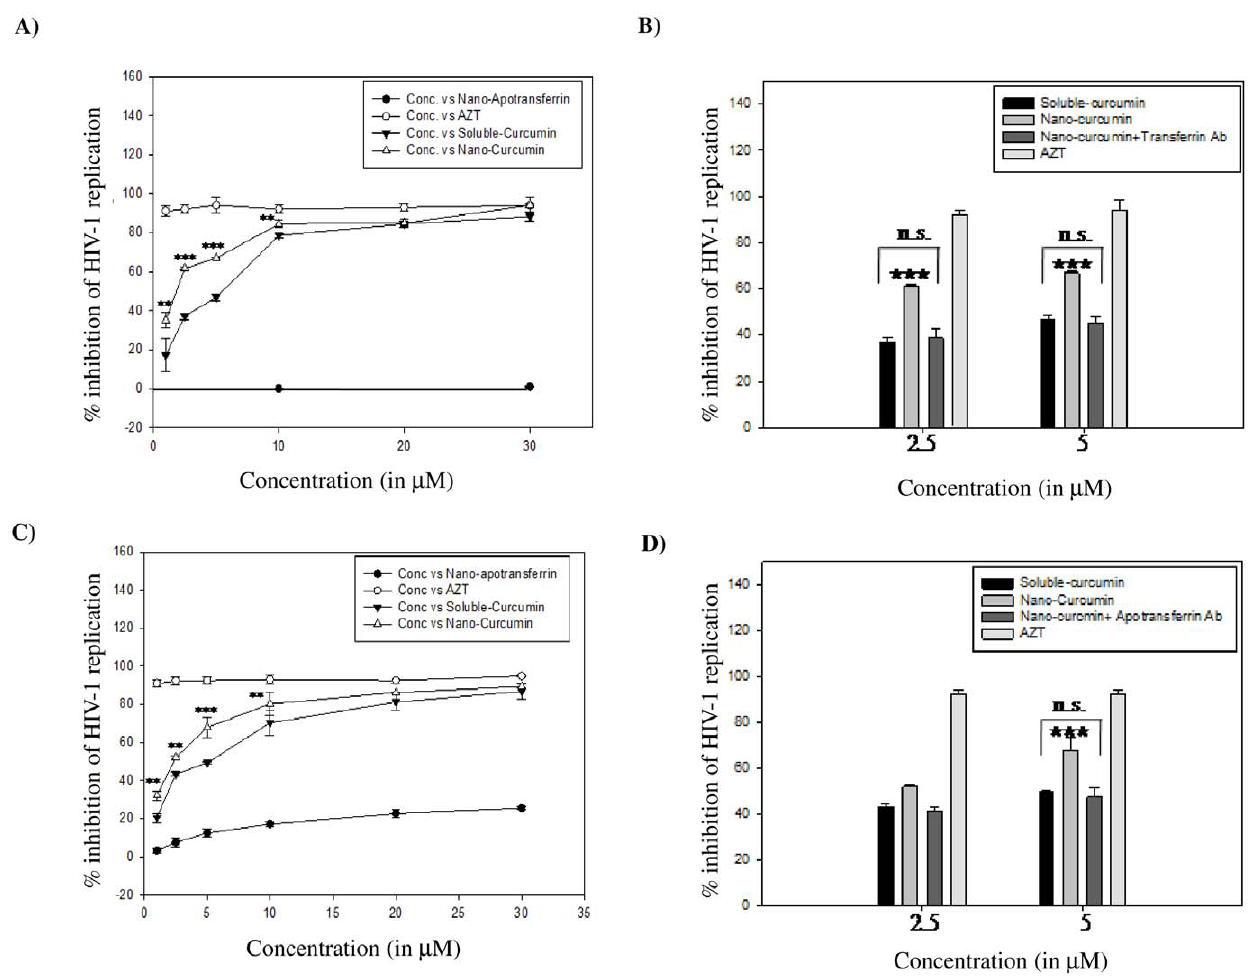
Figure 6. Nano-curcumin more effectively inhibits HIV-1 replication through a mechanism dependent on transferrin receptor. A & C) SUPT1 cells (Panel A) or stimulated PBMCs (Panel C) were challenged for 2 h with HIV-1 93IN101 (1 mg p24/ml) in the presence of increasing concentrations (1, 2.5, 5, 10, 20 and 30 m M) of sol-curcumin, nano-curcumin, or nano-apotransferrin (10 and 50 m g). They were then incubated for a further 96 h, after which viral replication was measured by p24 antigen capture assay. *indicates m g apotransferrin protein that carry equivalent molar concentration of the drug. B & D) SUP-T1 cells or stimulated PBMCs were challenged for 2 h with HIV-1 93IN101 in the presence of 2.5 or 5.0 m M concentrations of sol-curcumin, nano-curcumin or nano-curcumin in the presence of transferrin receptor antibody (100 ng/ml). After 96 h incubation, viral replication was measured by p24 antigen capture assay. In both these experiments, viral replication in the absence of drug was defined as 0% inhibition; Azidothymidine (AZT) was employed as a positive control. Error bars indicate SD. ** P # 0.01, and ***, P # 0.001 compared to sol-curcumin; n.s.: non-significant.